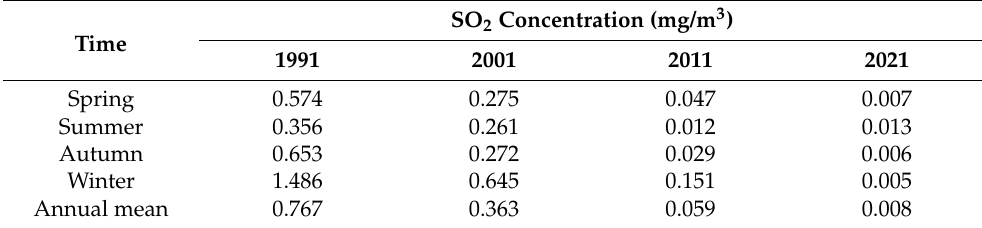
Figure 2. Average monthly variation of SO 2 concentration in the Yungang Grottoes. Table 1. Seasonal variations of SO 2 concentration in the Yungang Grottoes.